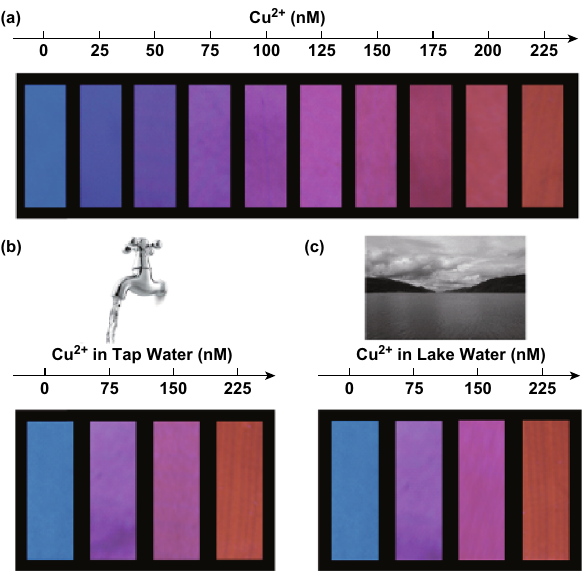
Fig. 16 a Visual detection of Cu 2 ? ions using filter papers printed with dual-colored CDs, and visual detection of Cu 2 ? in b tap water and c lake water. All images were taken under 365 nm illumination [147]. Copyright (cid:2) 2017 American Chemical Society.